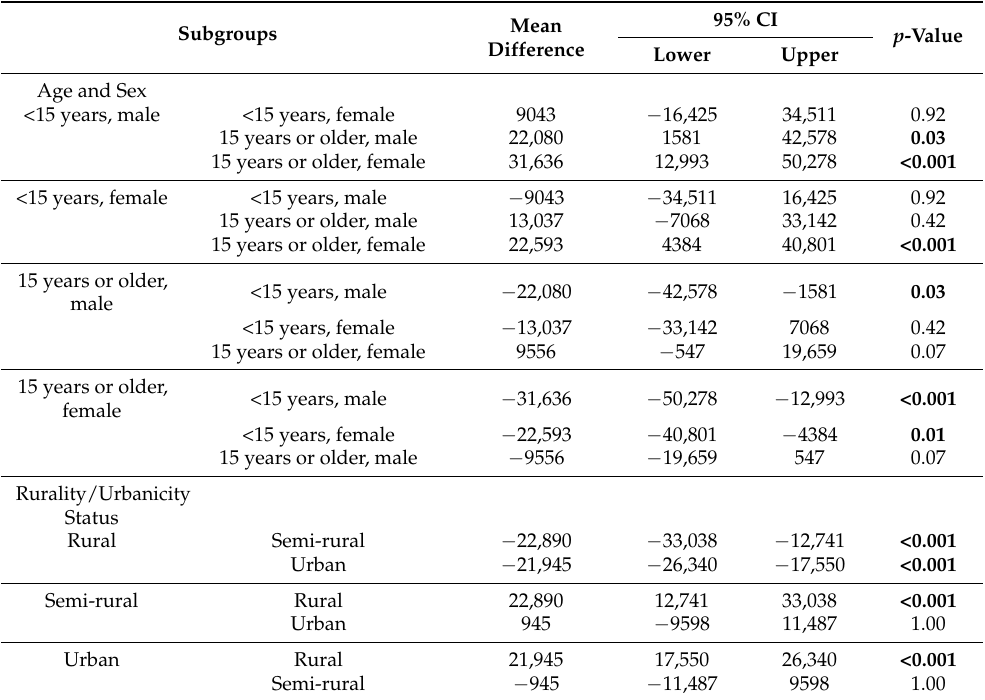
Table 3. Multiple comparisons of mean viral loads from ANOVA for independent variables with >2 categories in HIV/AIDS clinics of Haut-Katanga and Kinshasa provinces, DRC,